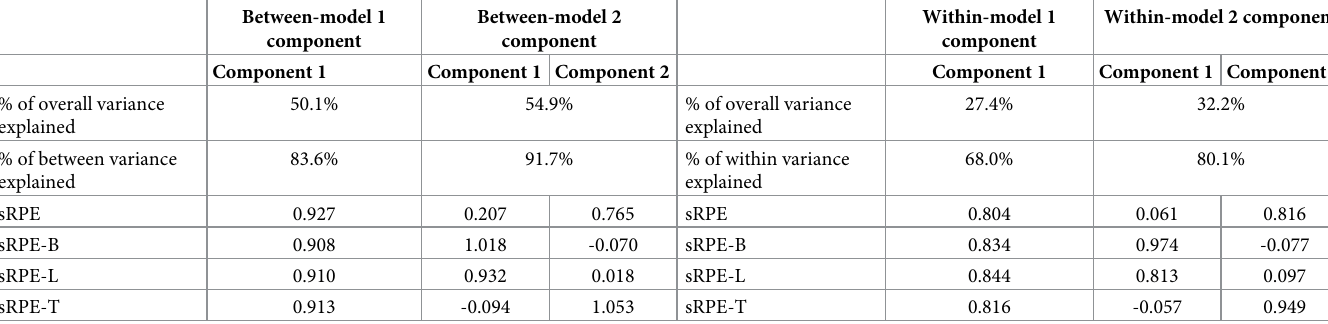
Table 3. MLSCA between- and within-model component loadings and percentage of explained